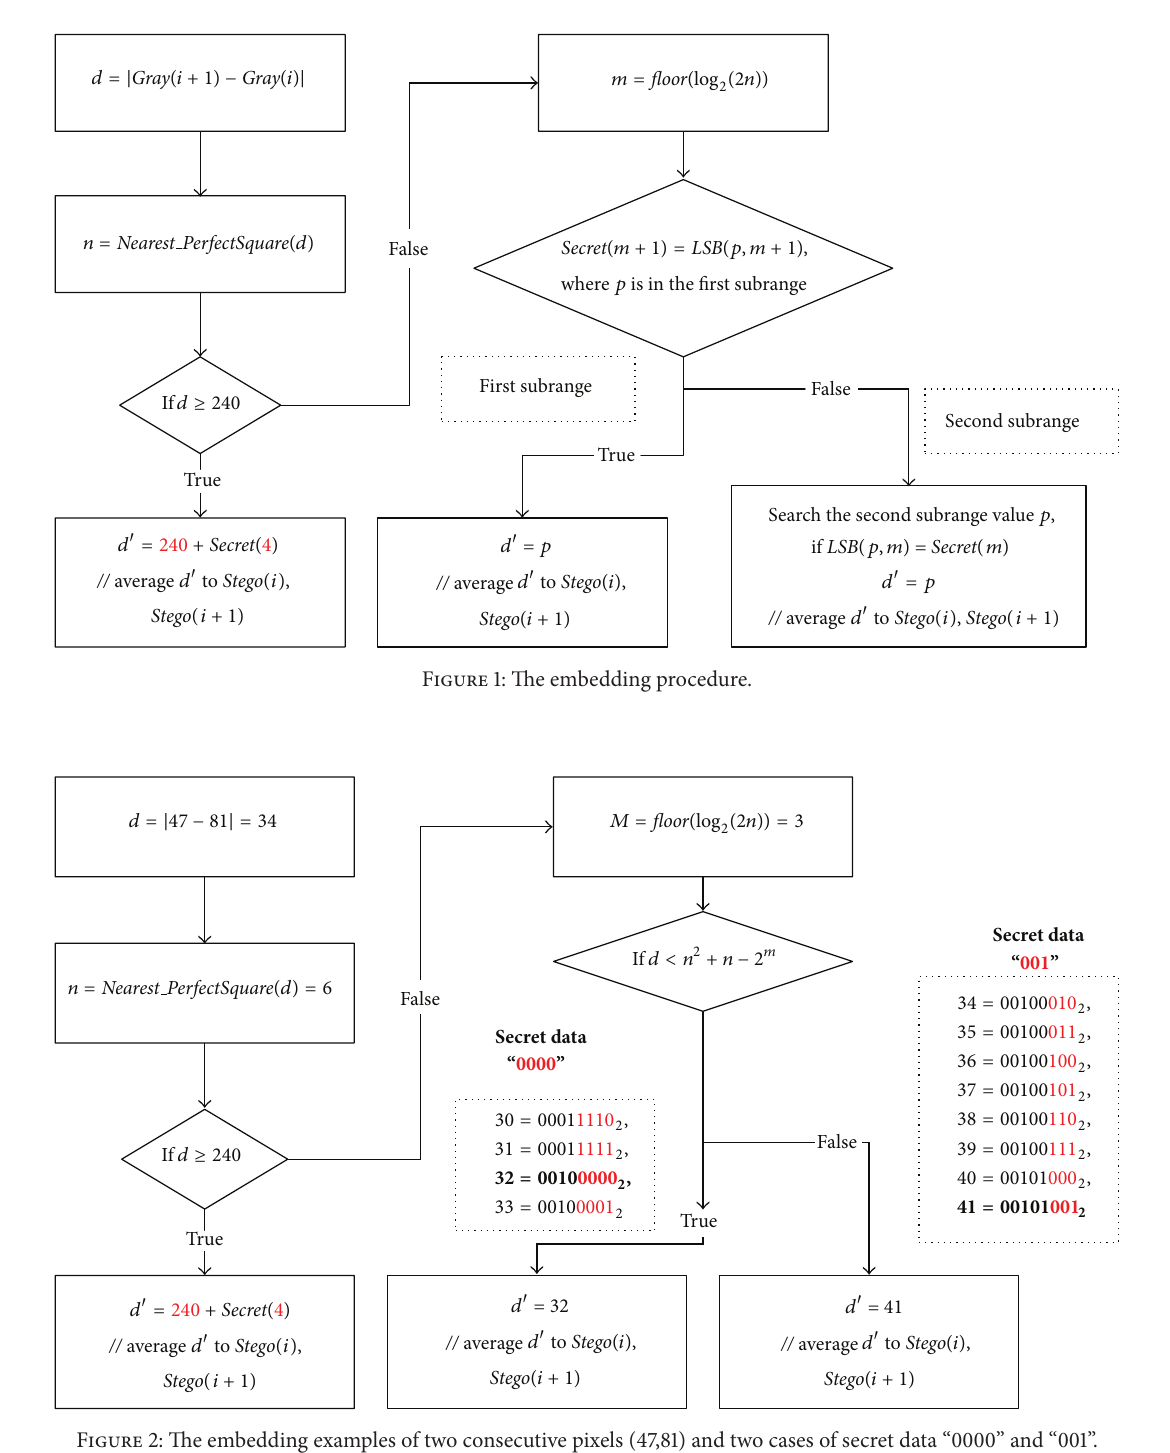
Step 1. For each pair of two consecutive pixels, compute the difference value 𝑑 󸀠 = |𝑆𝑡𝑒𝑔𝑜(𝑖 + 1) − 𝑆𝑡𝑒𝑔𝑜(𝑖)| .